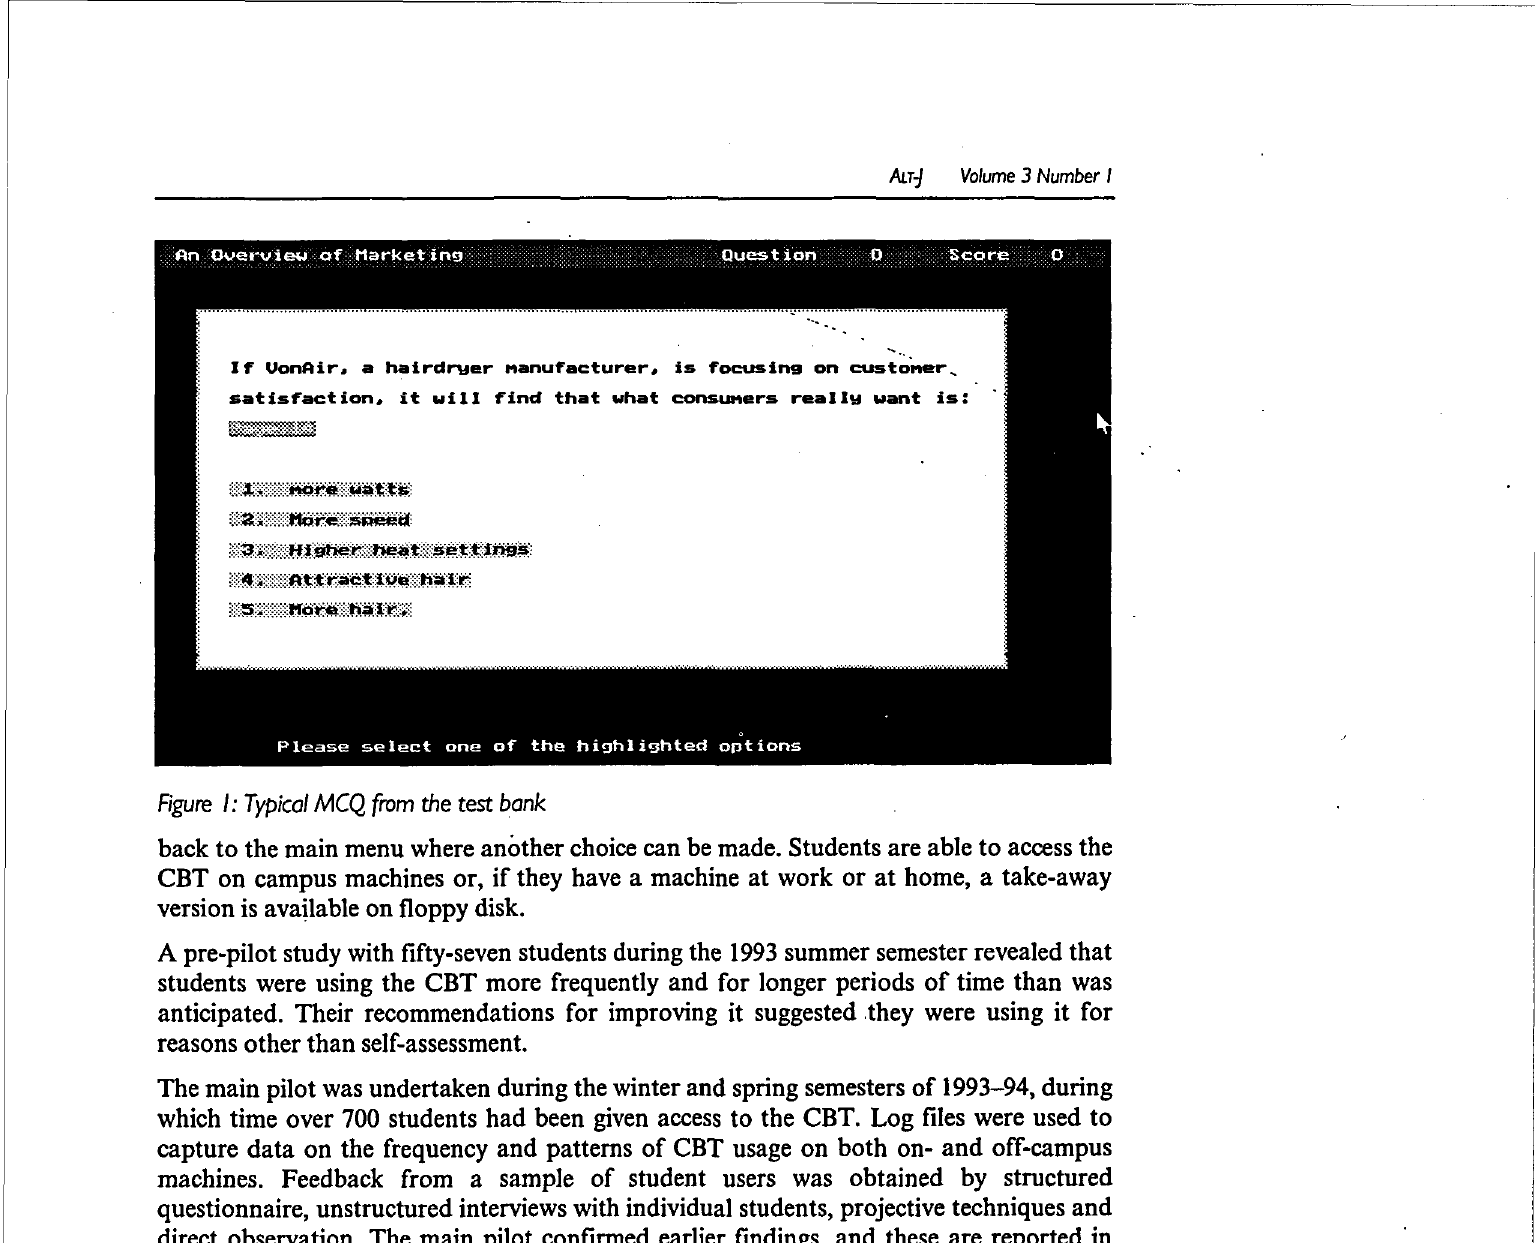
Figure /: Typical MCQ from the test